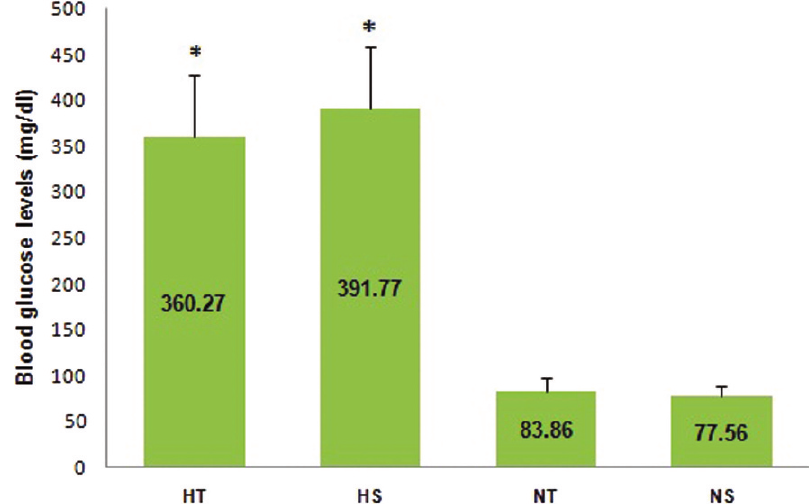
Figure 1 - Blood glucose levels hot plate of the trained STZ-induced diabetic (HT, n=11), sedentary STZ-induced diabetic (HS, n=9), normoglycemic trained (NT, n=14) and normoglycemic sedentary (NS, n=16) groups before the hot plate test. * p , 0.0001: different from NS and NT.